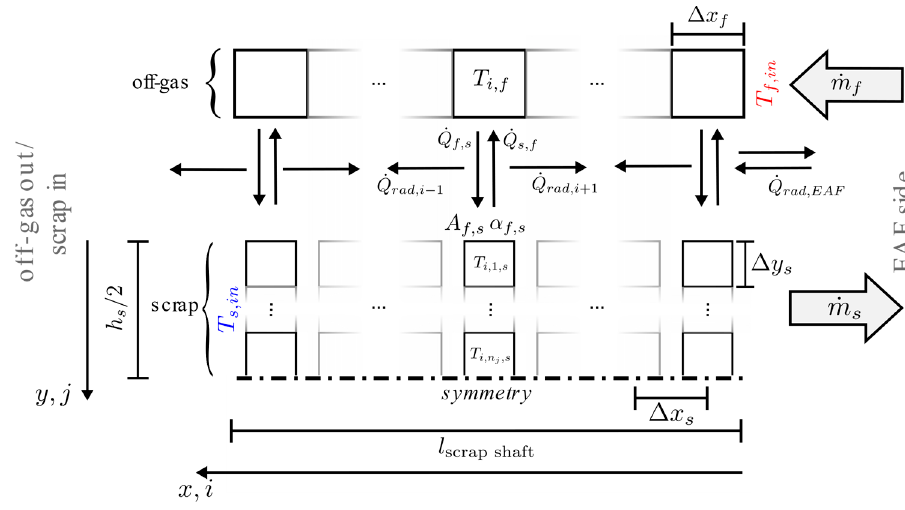
Figure 5. Modeling scheme of the 1D(–1D) model.